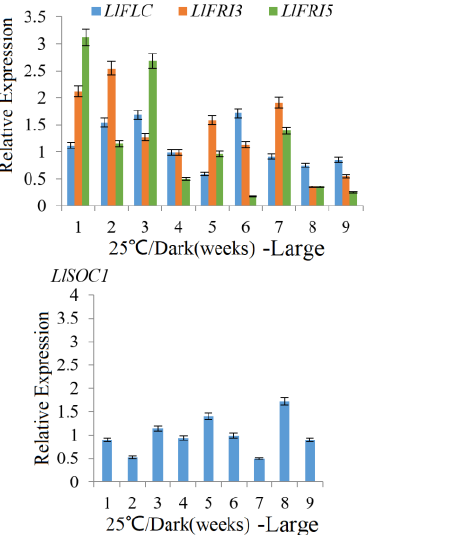
Figure 2. The expression patterns of LlFLC , LlFRI3 , LlFRI5 , LlVRN1 , LlVRN2 , LlSOC1 and LlFTs in scales of Lilium longiflorum before planting. Notes: Small and large meant bulb size. Relative expression levels were determined by qRT-PCR (y-axis). Data represented an average of three biological replicates with three technical replicates. Error bars represented SDEV of three biological replicates. The relative expression levels were calculated by the standard E −ΔΔCq method.